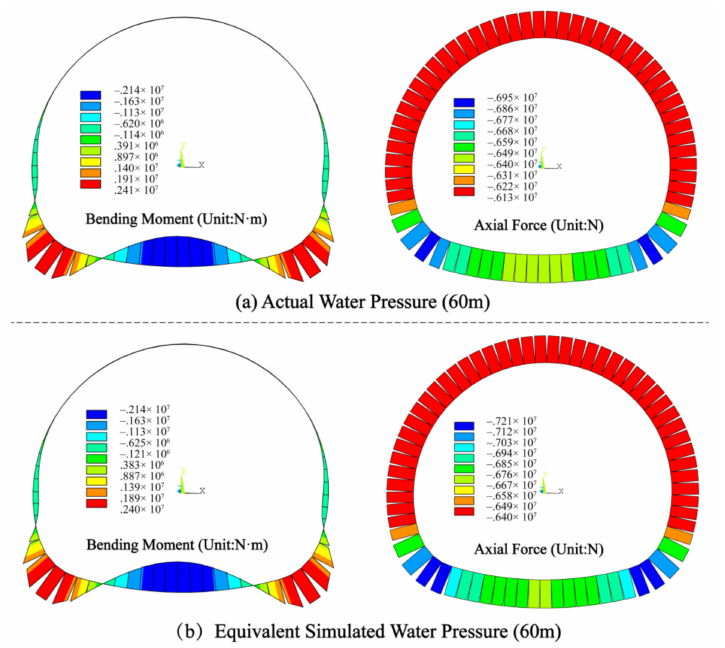
Figure 4. Comparison of the equivalent simulated water pressure and actual water-pressure